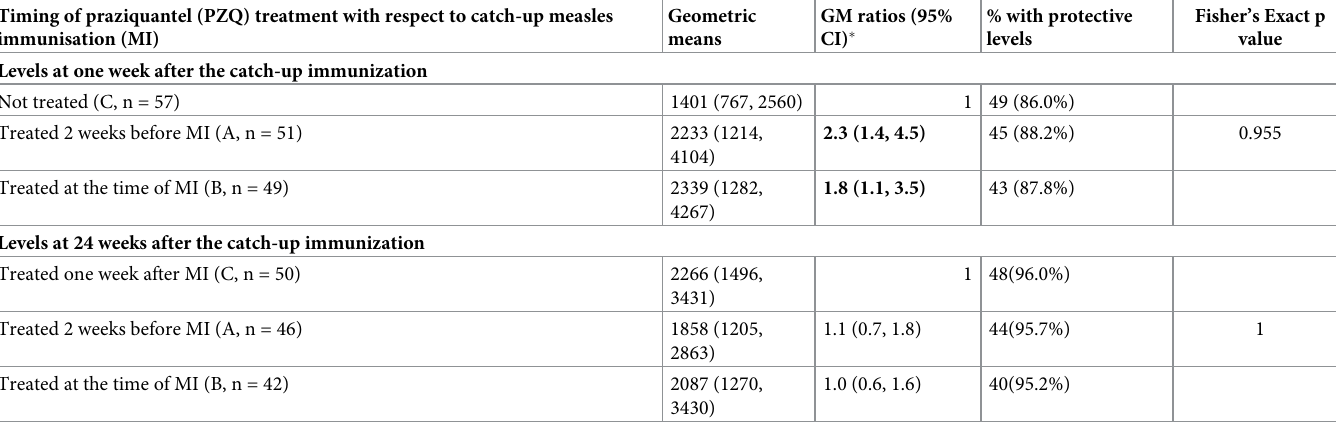
Table 4. Effect of praziquantel treatment on antibody